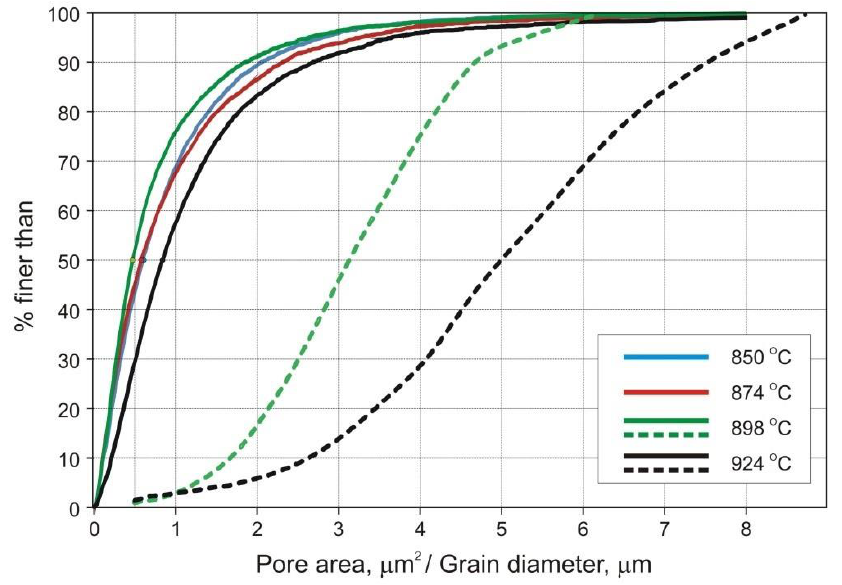
Figure 9. Cumulative plot of pore area (solid curves) and grain diameter d a (dashed curves) distri- butions.